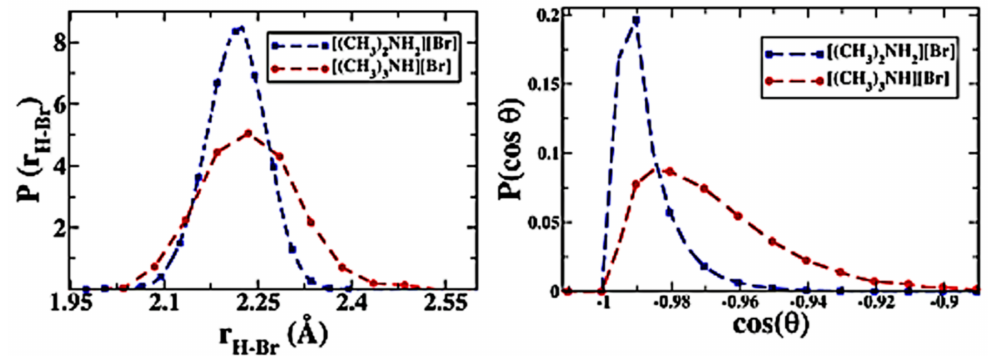
Figure 3. Normalized distribution of NH ··· Br bonding length (left) and N − H ··· Br angle (right) in [(CH 3 ) 3 NH]Br and [(CH 3 ) 2 NH 2 ]Br [40]. Reprinted with permission of American Chemical